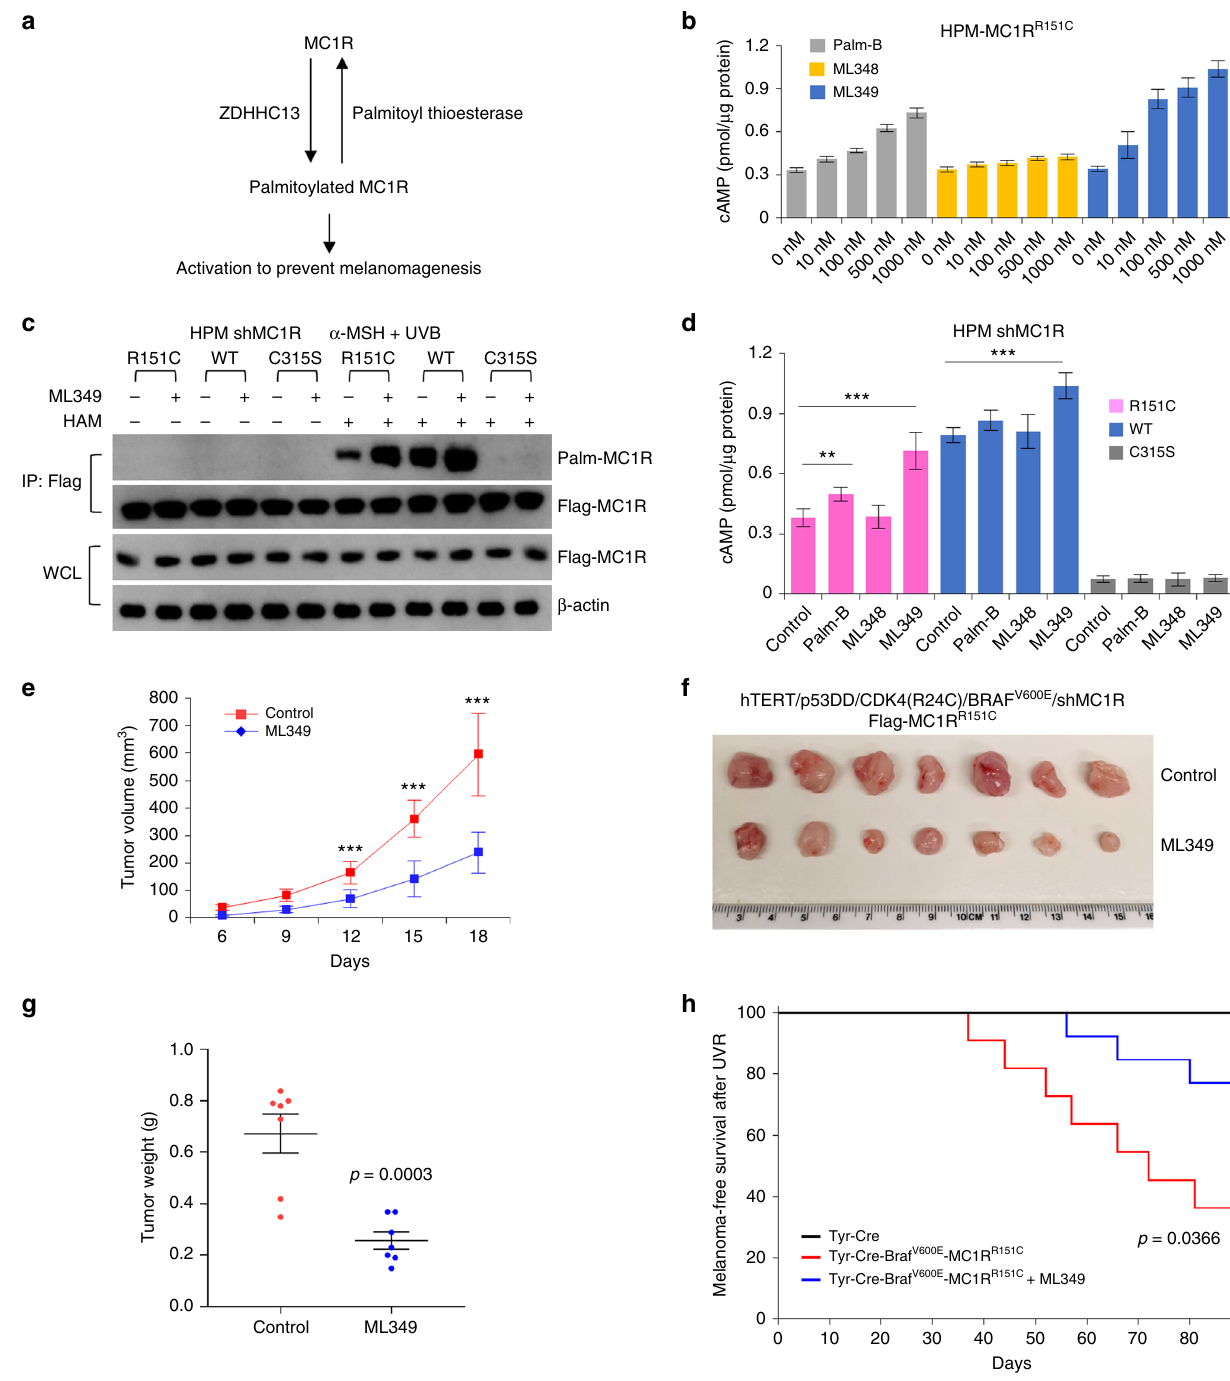
selective APT1 inhibitor and ML349 is a selective APT2 inhibitor 37 . We fi rst compared the effect of increasing concentrations (10, 100, 500, 1000 nM) of Palm-B, ML348, or ML349 on cAMP levels in human primary melanocytes (HPMs) engineered to express MC1R R151C together with α -MSH (1 µM). We found that ML349 was the most ef fi cient at increasing cAMP production in melanocytes expressing the MC1R R151C variant (Fig. 4b). These results suggest that ML349 potentially activates palmitoylation of MC1R and that targeted inhibition of APT2 inhibition might be a strategy to prevent melanomagenesis in